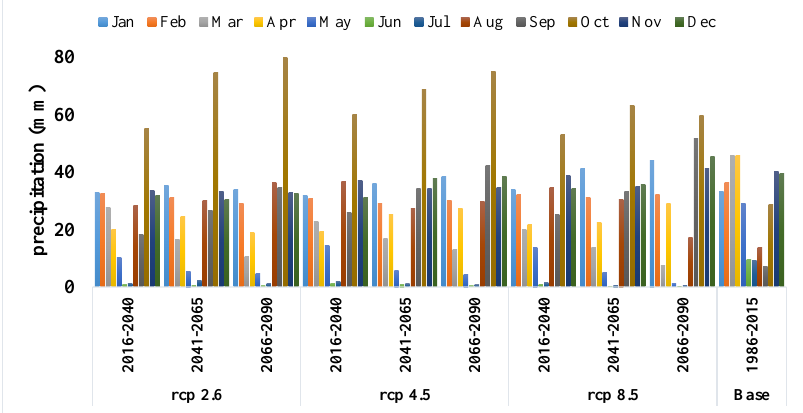
Figure 3. Comparison of the monthly precipitation of periods 2016–2040, 2041–2065, and 2066–2090 under scenarios rcp2.6, rcp4.5, and rcp8.5 with the baseline period.